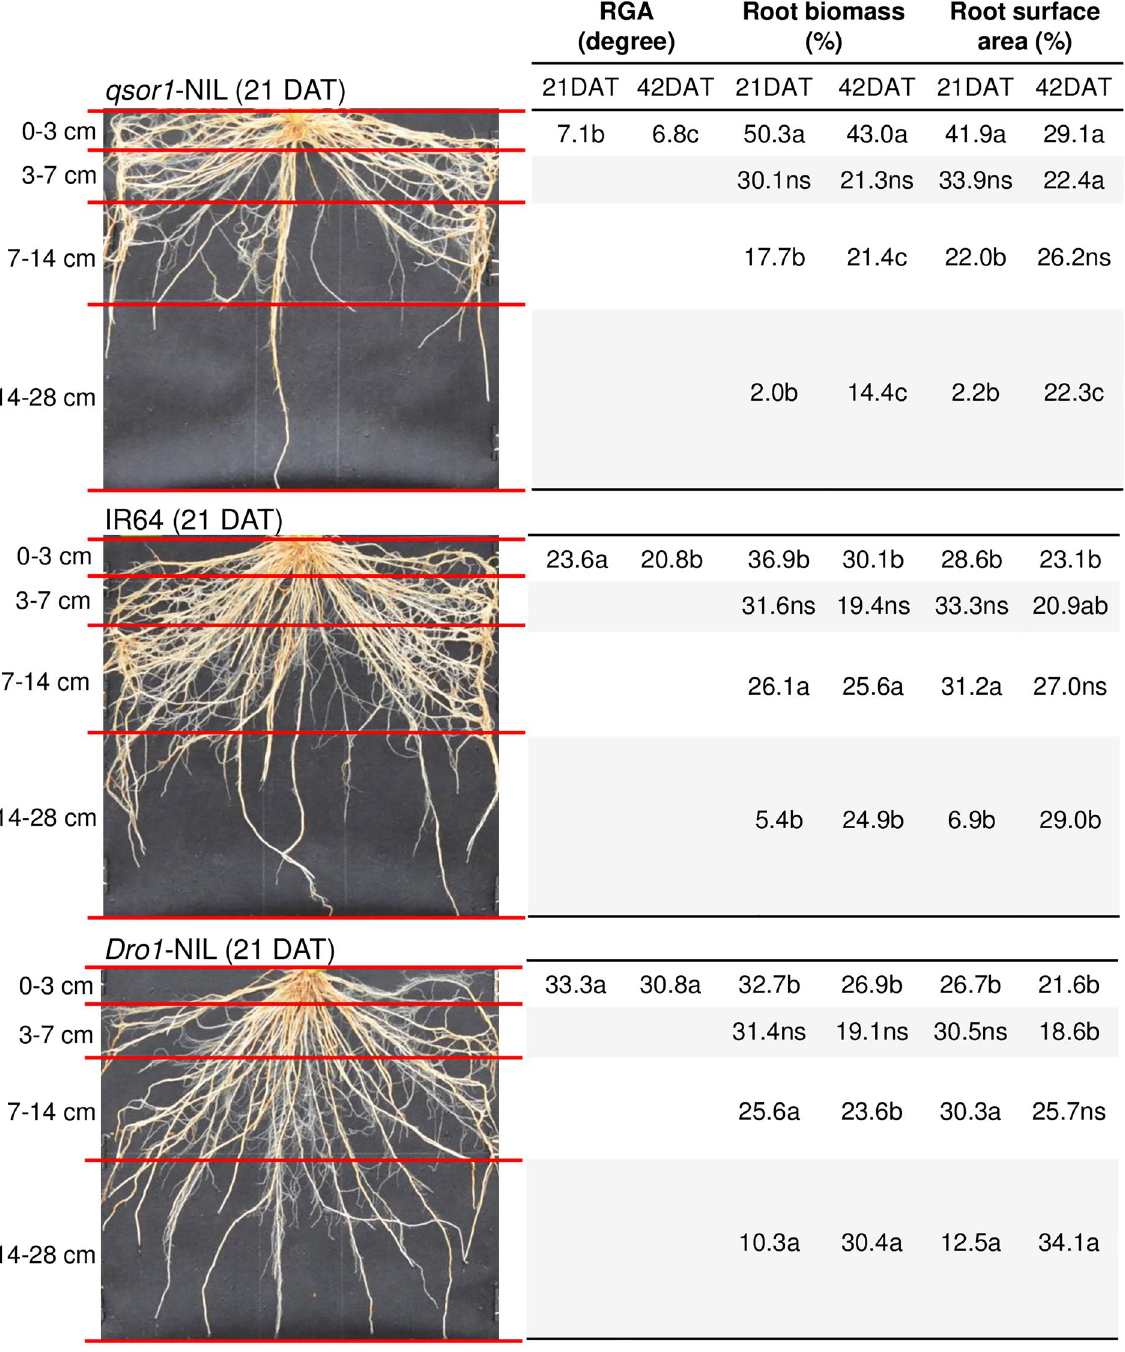
vs. 47% at 42 DAT, respectively), indicating more uniform and dispersed root development.